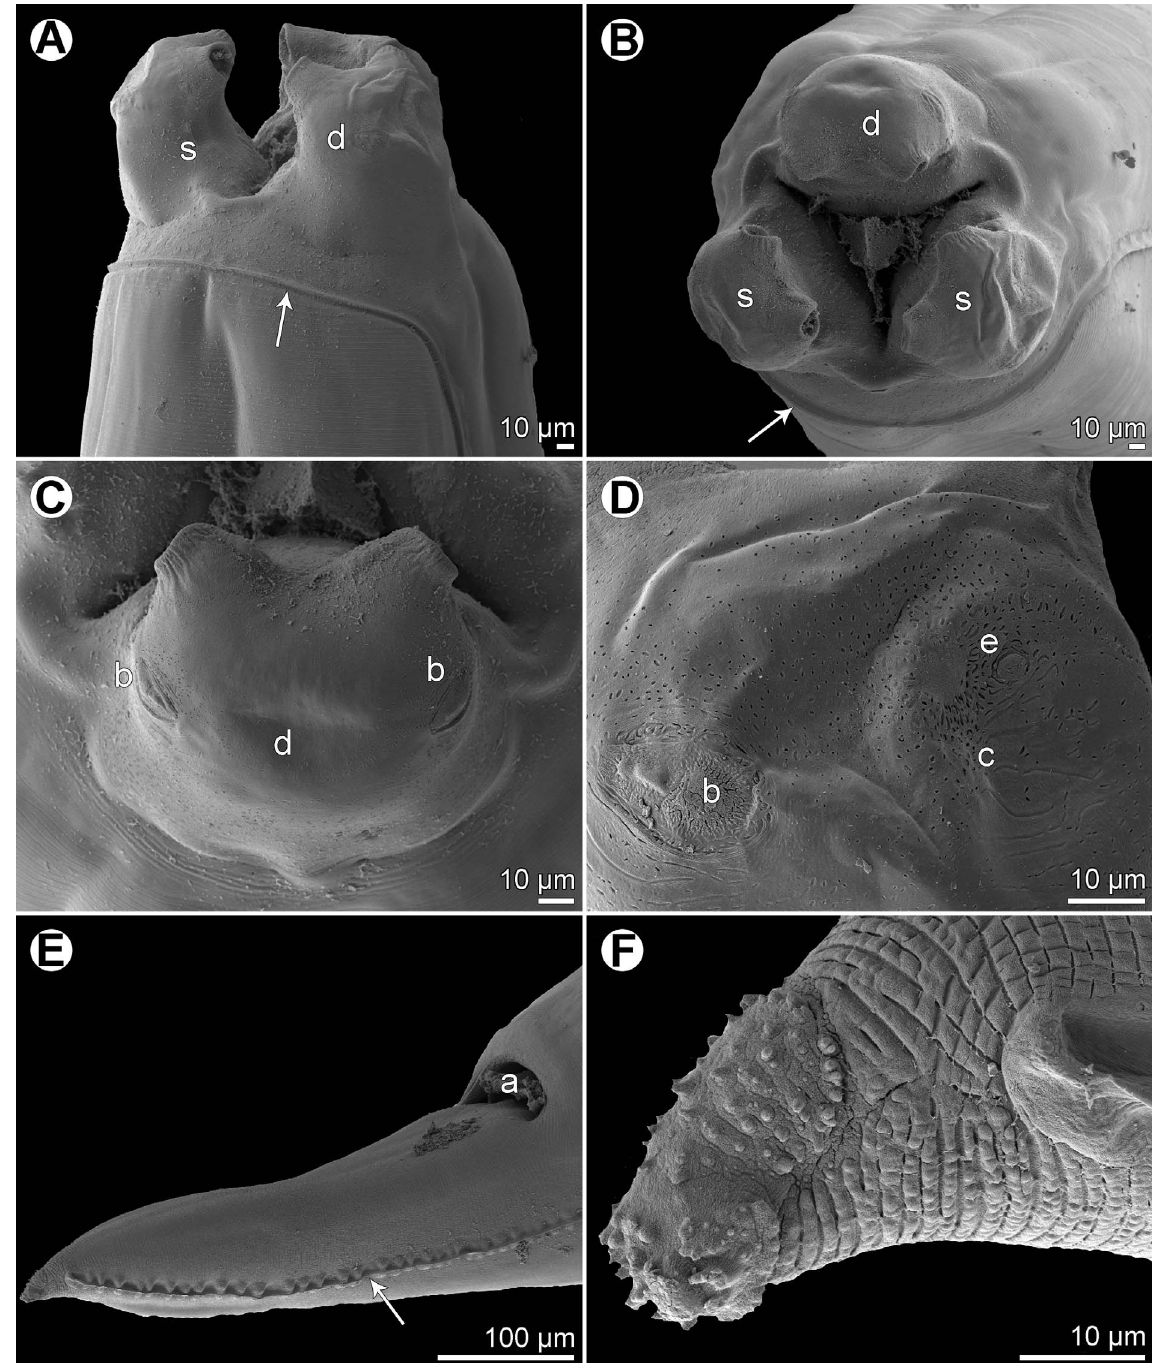
Figure 10. Raphidascaris ( Ichthyascaris ) euani n. sp., scanning electron micrographs of female. (A and B) Cephalic end, lateral and apical views, respectively (arrow indicates cuticular ala); (C) dorsal lip; (D) middle region of subventral lip; (E) tail, lateral view (arrow indicates lateral ala); (F) tail tip, lateral view. (a) Anus; (b) labial double papilla; (c) labial single papilla; (d) dorsal lip; (e) amphid; (s) subventral